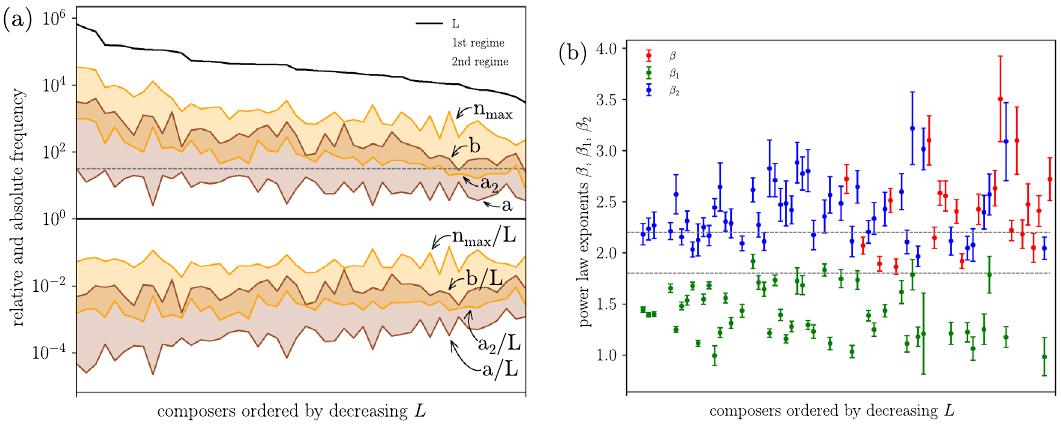
Figure 4. Results of the double power-law fit for each composer for which this is not rejected. ( a ) Fitting ranges sorted by decreasing L . Relative fitting ranges, in terms of cut-off frequencies divided by L , are also shown below. 1.5 ≃ 32 The dashed line marks the 10 limit. The middle region not in the legend corresponds to the overlap between both regimes. ( b ) Double power-law exponents β 1 and β 2 . The value of the exponent β for the simple power law (when this is not rejected) is also included. Horizontal dashed lines delimit the Zipf’s range for the exponents β 2 and β .